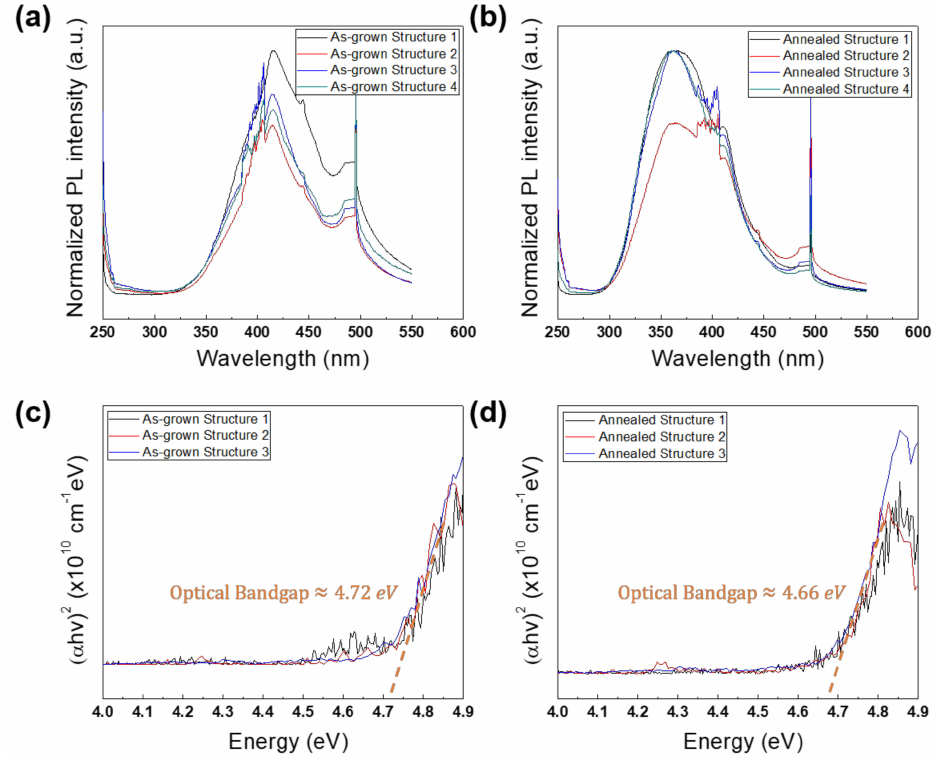
Figure 4. Photoluminescence spectra from all of the ( a ) as-grown and ( b ) annealed superlattice structures. Transmission measurement of ( c ) as-grown and ( d ) annealed superlattice layers for obtaining the optical